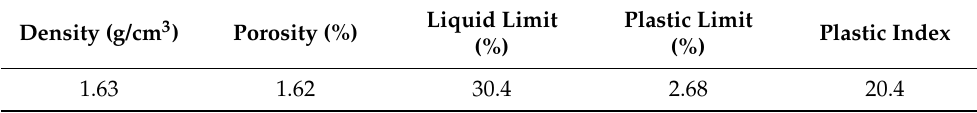
Table 1. Basic physical and mechanical properties of coastal soft soil.